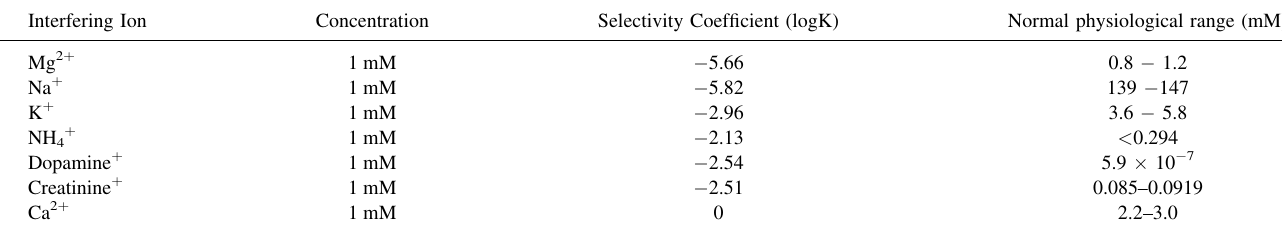
Table I. Selectivity coef fi cients for biologically relevant cations in cow blood vs calcium and the physiological ranges. Interfering Ion Concentration Selectivity Coef fi cient (logK)